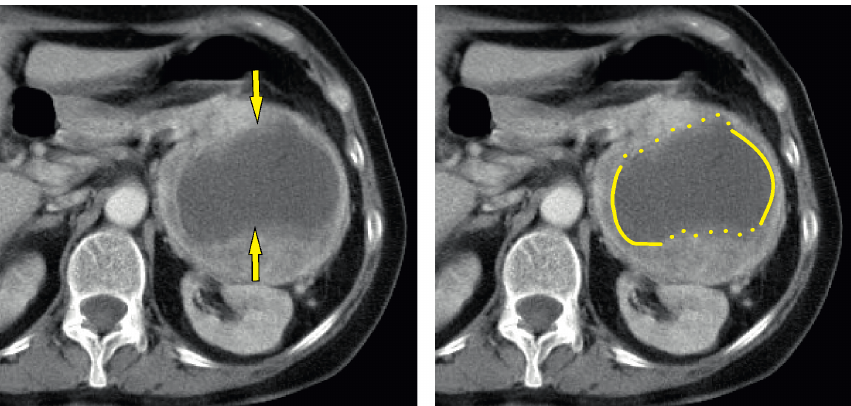
Fig. 2. Unsharp necrosis. The arrows point to the irregular borders. The uninterrupted closed line defines the borders of the sharp necrosis. The interrupted line defines the borders of the unsharp necrosis.